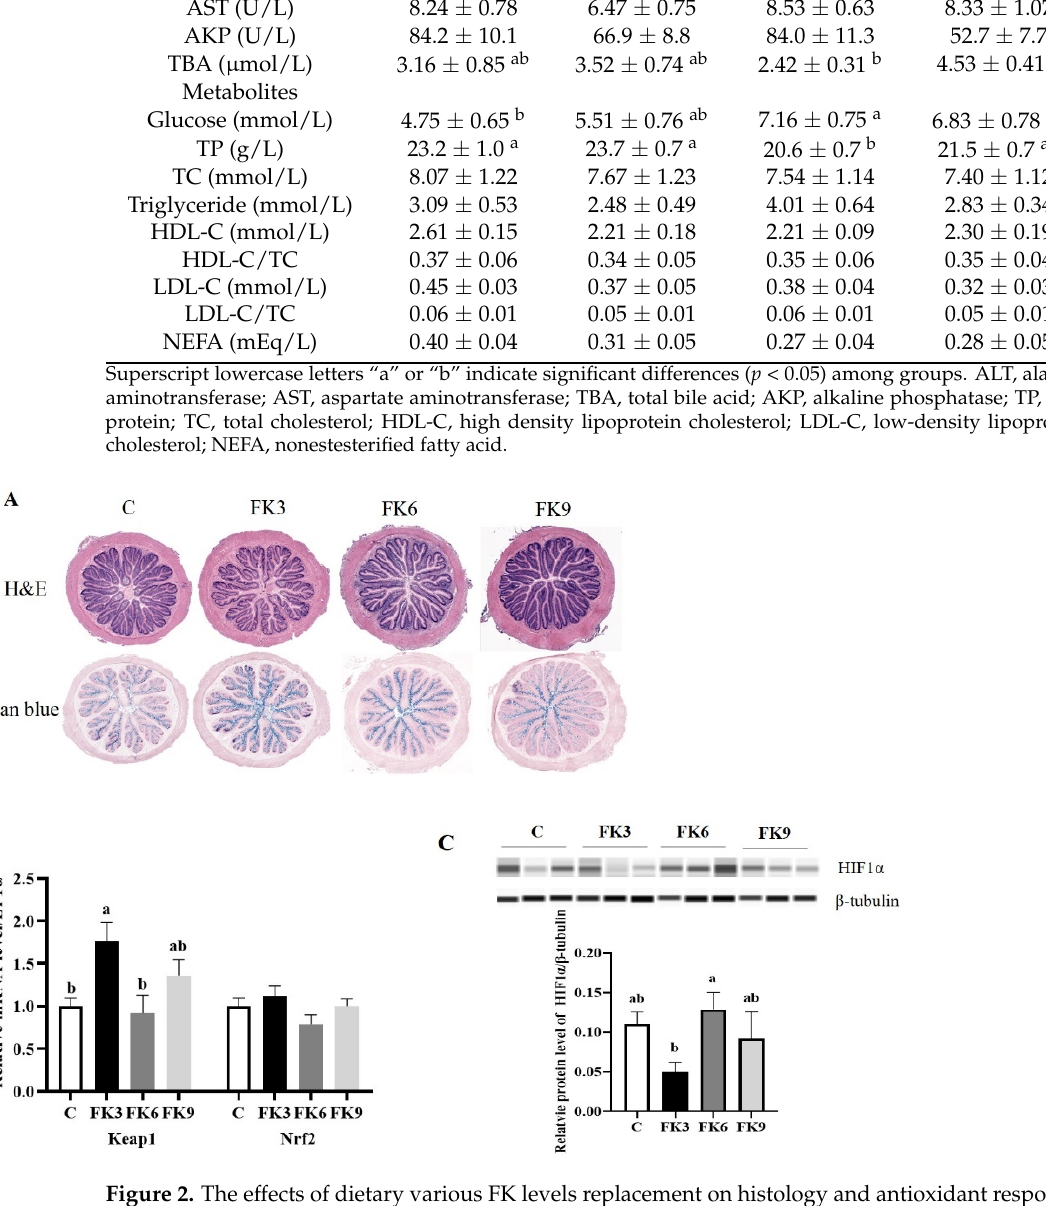
Figure 2. The effects of dietary various FK levels replacement on histology and antioxidant responses of distal intestine of largemouth bass. ( A ) The phenotypes of distal intestinal histopathological examination by H&E and Alcian blue staining ( n = 12); ( B ) The mRNA levels of Keap1 and Nrf2 ( n = 12). ( C ) The relative protein level of HIF1a ( n = 3). Different superscript letters “a” or “b” indicate significant differences ( p < 0.05), whereas the same superscript letters show no significant differences among groups (means ± SEM). Table 8. Antioxidant response in plasma and hepatic tissue of largemouth bass fed diets with vari- ous FK levels (means ± SEM. n = 12).